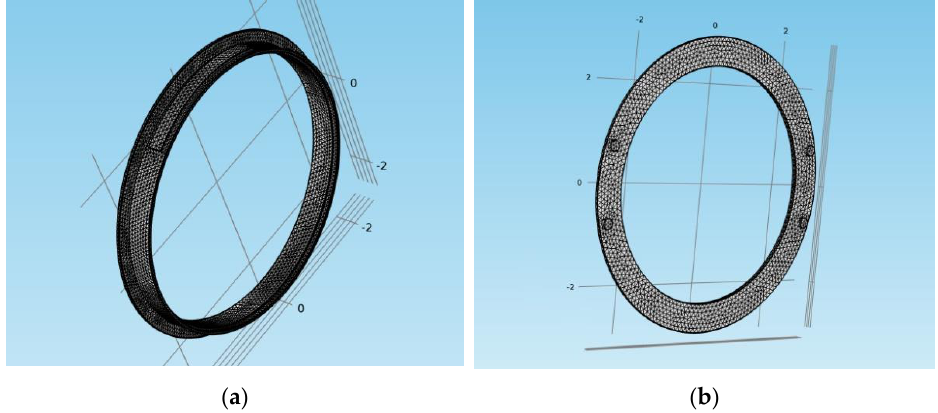
Figure 13. The mesh of COMSOL model: ( a ) drum-and-shoe brake system; ( b ) disc-and-pads brake system.